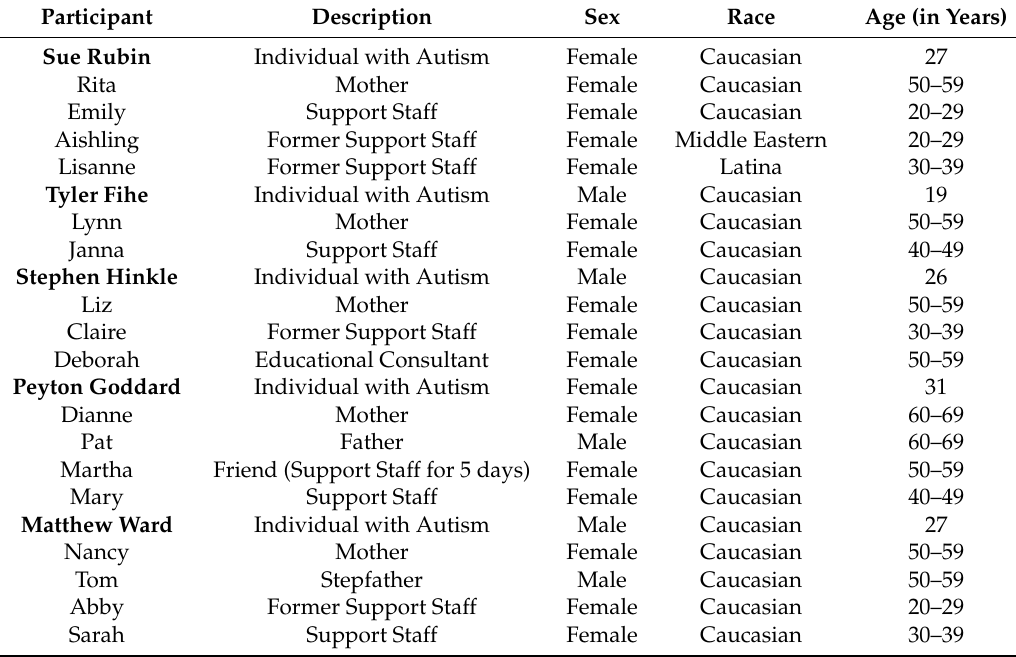
Table 1. Description of